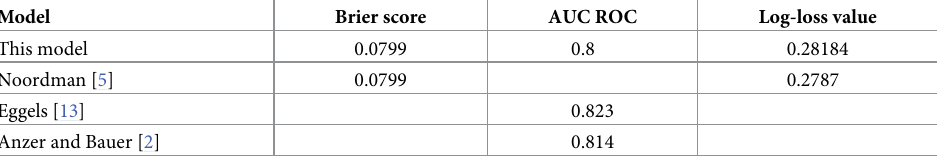
Table 3. Summary of the results of our model compared to published models. The AUC ROC for the optimal model in this research used test data, and used players’ FIFA ratings as a proxy for player ability.